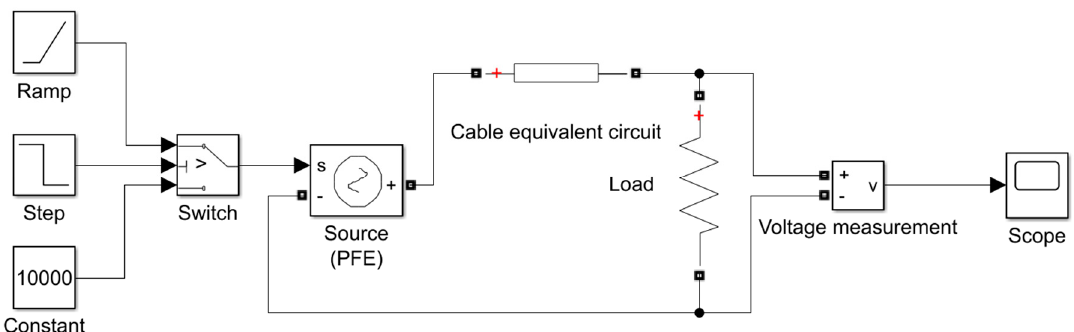
Figure 3. The simulation file for comparing different submarine cable models.